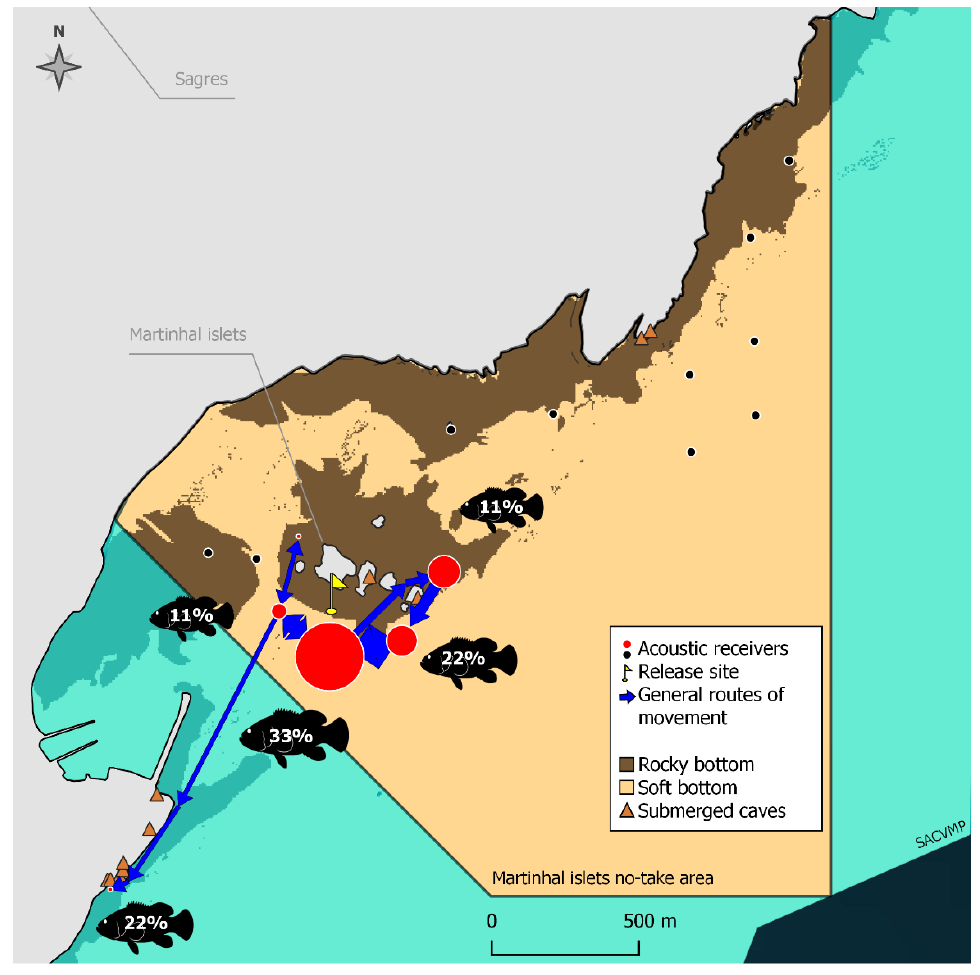
Figure 6. General routes of short-distance ranging movements of nine of the ten dusky groupers released in Martinhal islets no-take area. Nodes represent acoustic receivers (with detections — red; without detections — black) and the size of the circles are proportional to the number of detections logged in each receiver. The edge’s thickness is proportional to the number of movements between two nodes and arrows represent the direction of the predominant movement directionality. Per- centages associated with the dusky groupers’ silhouettes represent the proportion of individuals detected for the last time in the respective location. The light blue indicates buffer areas of the marine park (SACVMP).